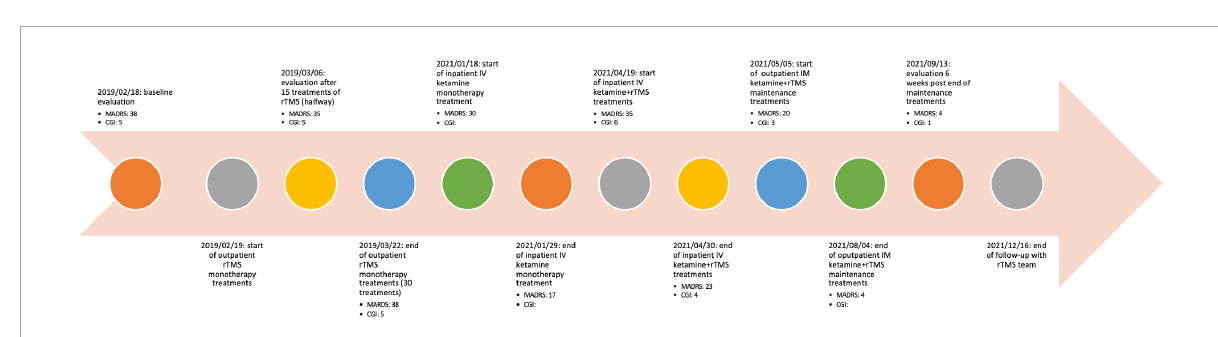
FIGURE3 Detailed timeline of significant events and scores on rating